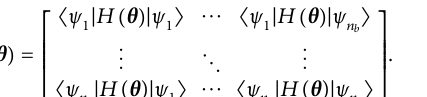
Figure 1 motivates the ef fi cacy of snapshot-based trial functions. Although a given eigenvector | ψ ( θ ) 〉 obtained from a high- fi delity solver resides in a high-dimensional (or even in fi nite-dimensional) space, the trajectory traced out by continuous variations in θ remains in a relatively low- dimensional subspace (as illustrated by the gray plane). Hence, linear combinations of high- fi delity eigenvectors spanning this subspace ( i.e. , the snapshots) make extremely effective trial wave functions for variational calculations. In nuclear physics, snapshot-based emulators already have accurately approximated ground-state properties, such as binding energies, charge radii [7, 9, 25], and transition matrix elements [9, 29], and have been explored for applications to excited states